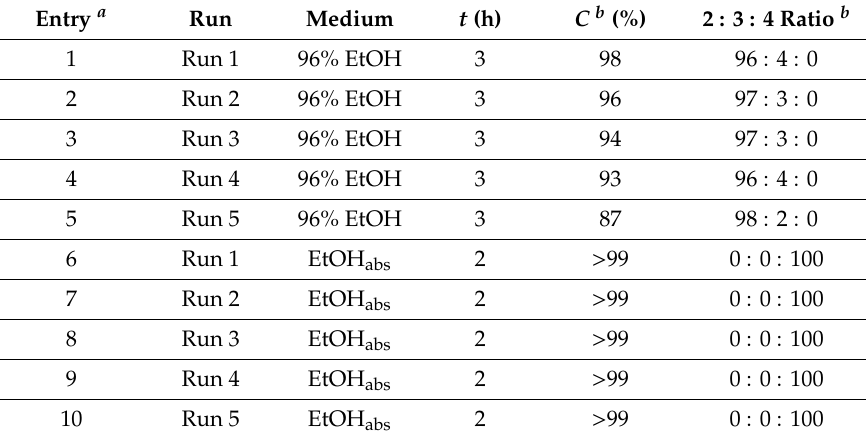
Scheme 2. Representative reduction of nitroarenes using Au@ZP–AEP as the catalyst and NaBH 4 as the reducing agent. Table 2. Representative results of Au@ZP–AEP catalyst in the switchable preparation of an azoxy derivative ( 2a ) and methoxyaniline ( 4a ) and its recovery and reuse. Reprinted with permission from reference. [111]. Copyright 2019, Royal Society of Chemistry.